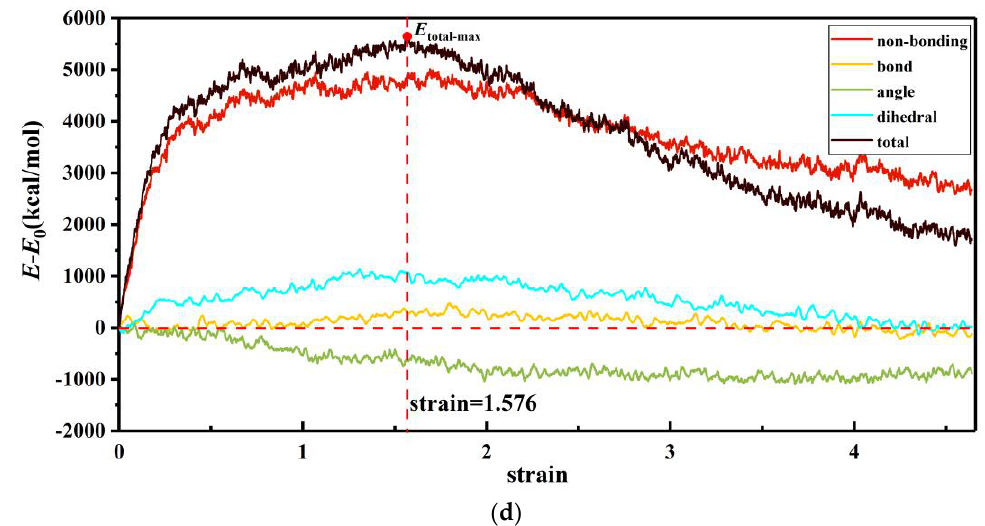
Figure 6. Energy decomposition for the PI system with different degrees of polymerization: ( a ) p = 50, ( b ) p = 100, ( c ) p = 150, ( d ) p = 200.